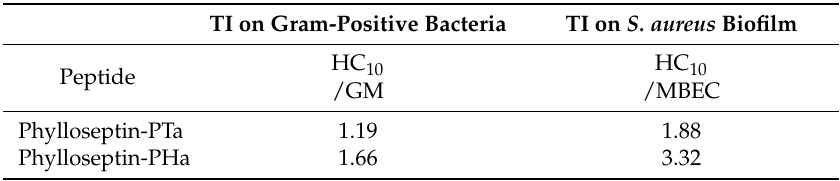
aureus biofilm eradicating agents Table 3. TIs of phylloseptin-PTa and phylloseptin-PHa as Gram-positive bacteriostatic agents and S.